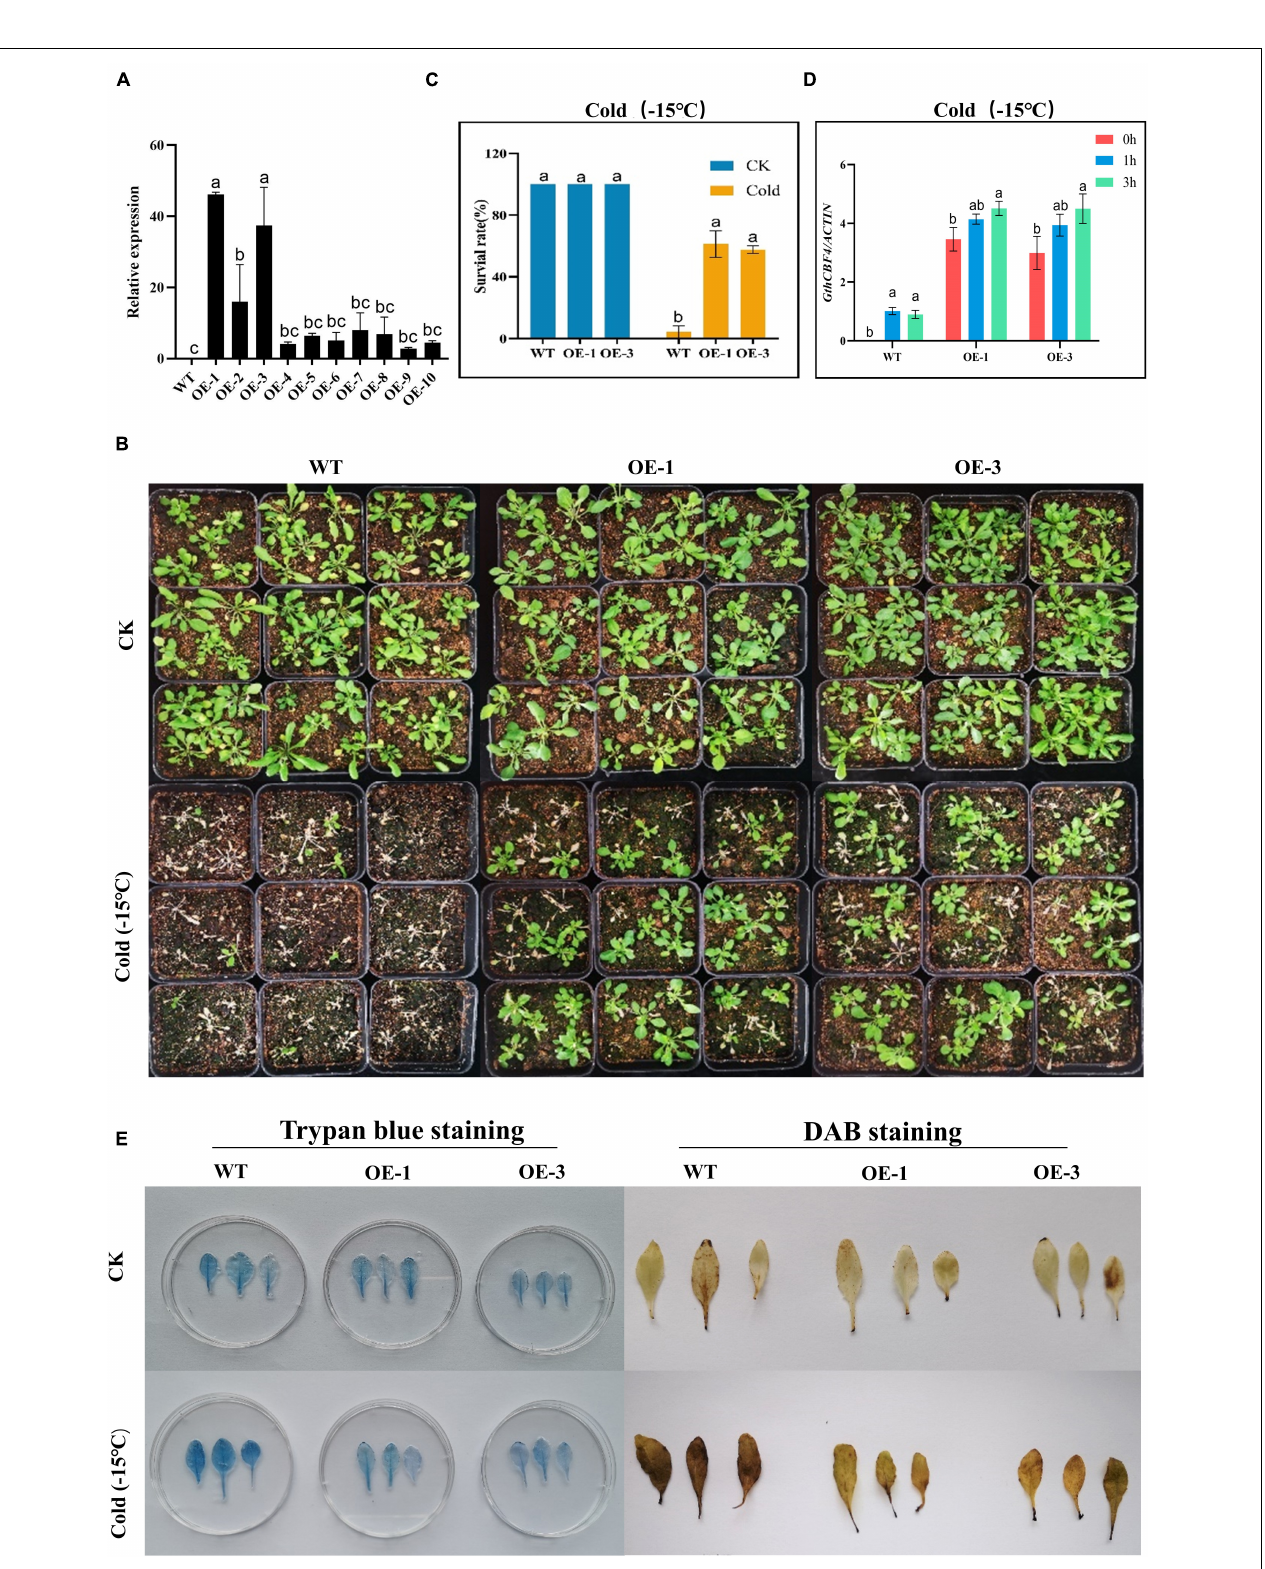
FIGURE 6 | Phenotype identification and cell damage identification of GthCBF4-overexpressed Arabidopsis under low temperature. (A) The quantitative expression level of GthCBF4 gene in transgenic Arabidopsis. (B) –15 ◦ C treatment restores the growth status of wild-type and transgenic Arabidopsis thaliana after culture. (C) Freezing survival assay. (D) Log10 (fold change) of the GthCBF4 genes expression in –15 ◦ C treatment. (E) Trypan blue staining and DAB staining. The letters a/b indicate statistically significant differences (two-tailed, p < 0.05) between the samples in each treatment.